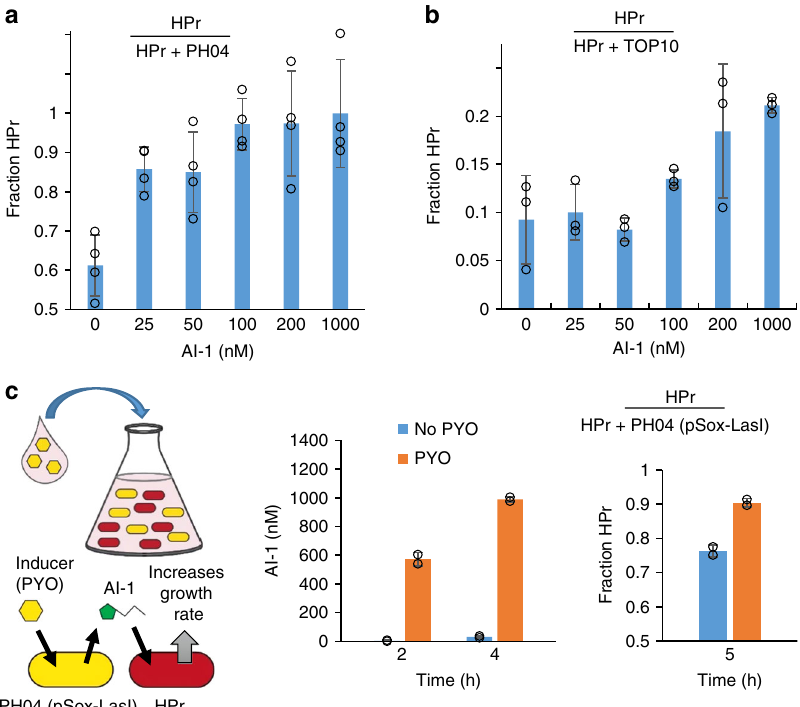
Fig. 3 AI-1 regulates cell growth rate in co-cultures. a PH04 pAHL-HPr (abbreviated as HPr) co-cultured with PH04 pCT6 (abbreviated PH04). Each culture was inoculated 0.5% for an initial HPr fraction of ~0.5. Indicated AI-1 level was added during inoculation. Samples were collected for analysis of co- culture composition after 8 h. Error bars represent s.d. of technical quadruplicates. b PH04 pAHL-HPr (abbreviated as HPr) co-cultured with TOP10 pT5G (abbreviated as TOP10). Each culture was inoculated 0.5% for an initial HPr fraction of ~0.5. Indicated AI-1 level was added during inoculation. Samples were collected for analysis of co-culture composition after 8 h. Error bars represent s.d. of technical triplicates. c PH04 pAHL-HPr (abbreviated as HPr) co- cultured with PH04 pSox-LasI with or without 1 µ M PYO induction. Initial fraction HPr in co-culture was ~0.5. Samples collected for AI-1 measurement after 2 h and 4 h and co-culture composition analysis after 5 h. Error bars represent s.d. of biological duplicates. Source data are provided as a Source Data fi le